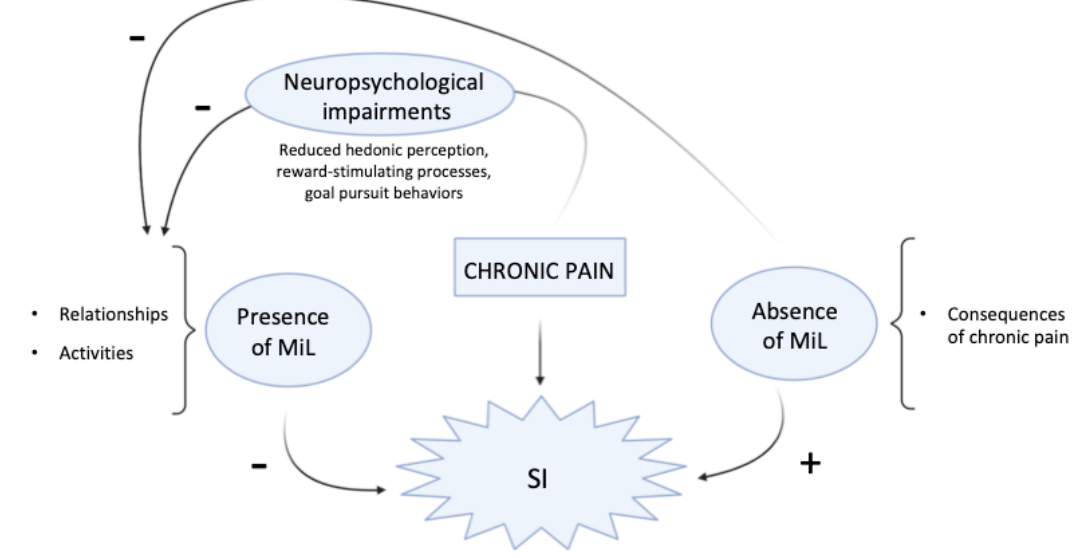
Figure 1. Pathways from chronic pain to suicidal ideation (SI): A vicious circle in a biopsychosocial framework. MiL: meaning in